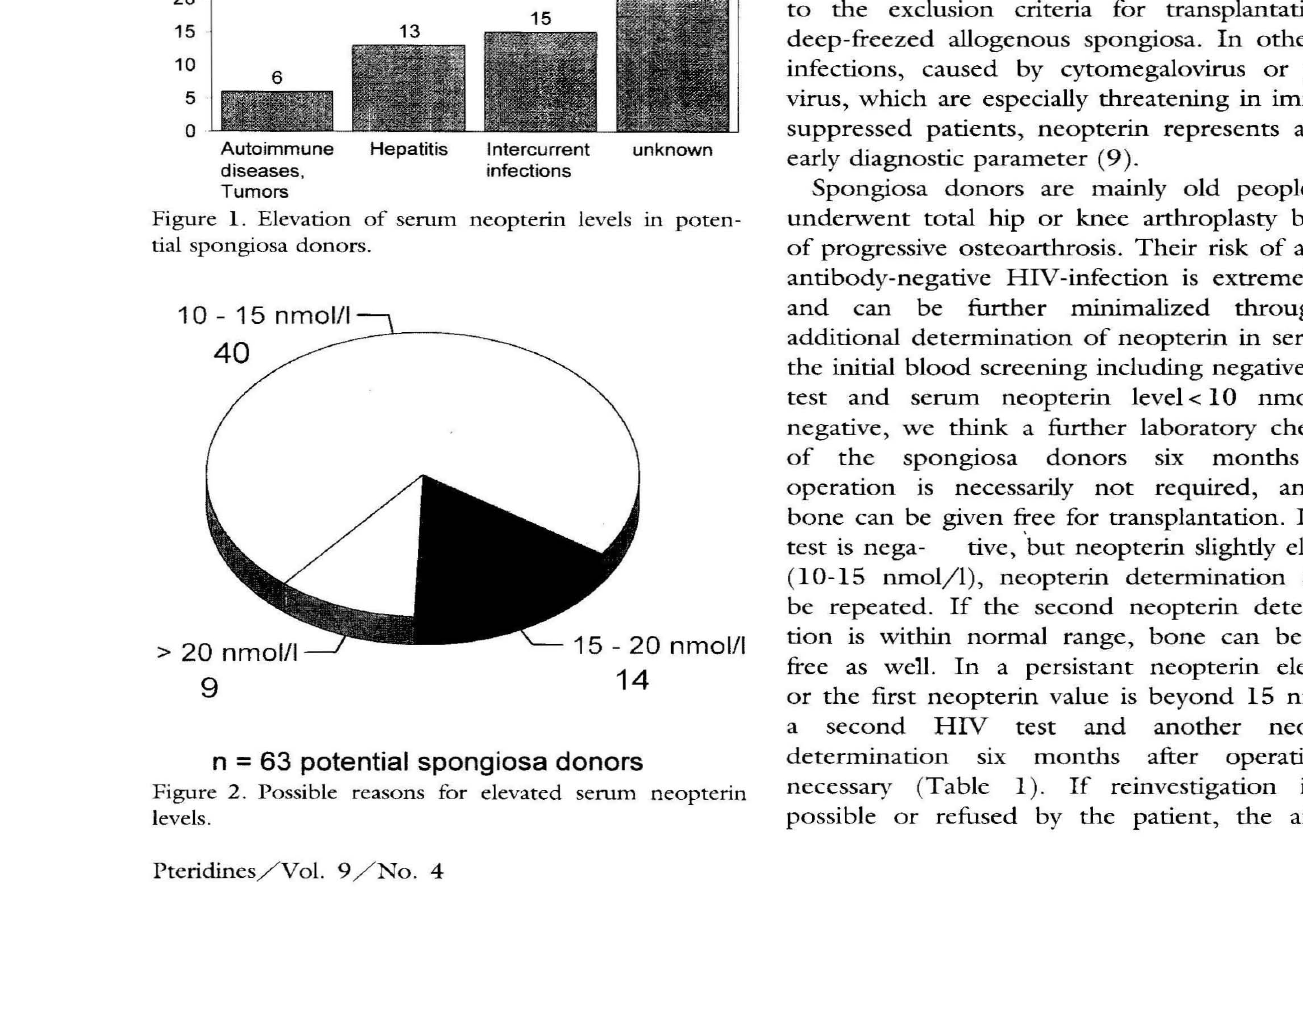
Figure 1. Elevation of serum tial spongiosa donors.